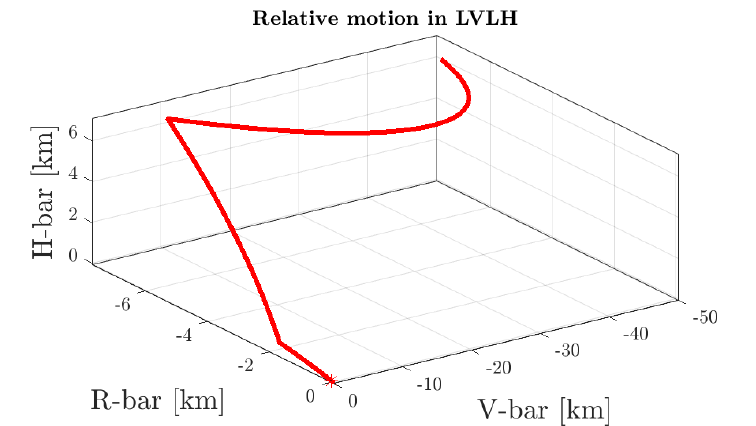
Figure 27. Rendezvous